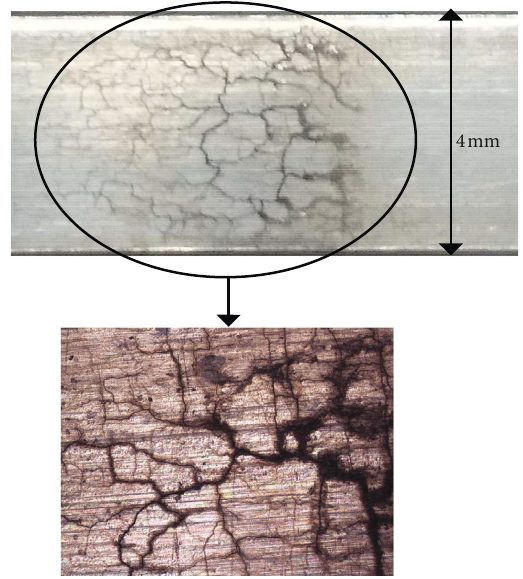
Figure 6: Optical micrograph of the damage after an AC break- down event of a sample with multiple layered heat shrink. Optical micrograph shows the damage to both the heat shrink and metallic surface of the HTS